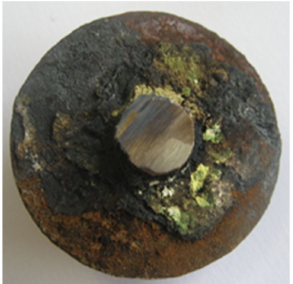
Figure 10. Photo of a sample of H24JS steel after exposure in the boiler combustion chamber.